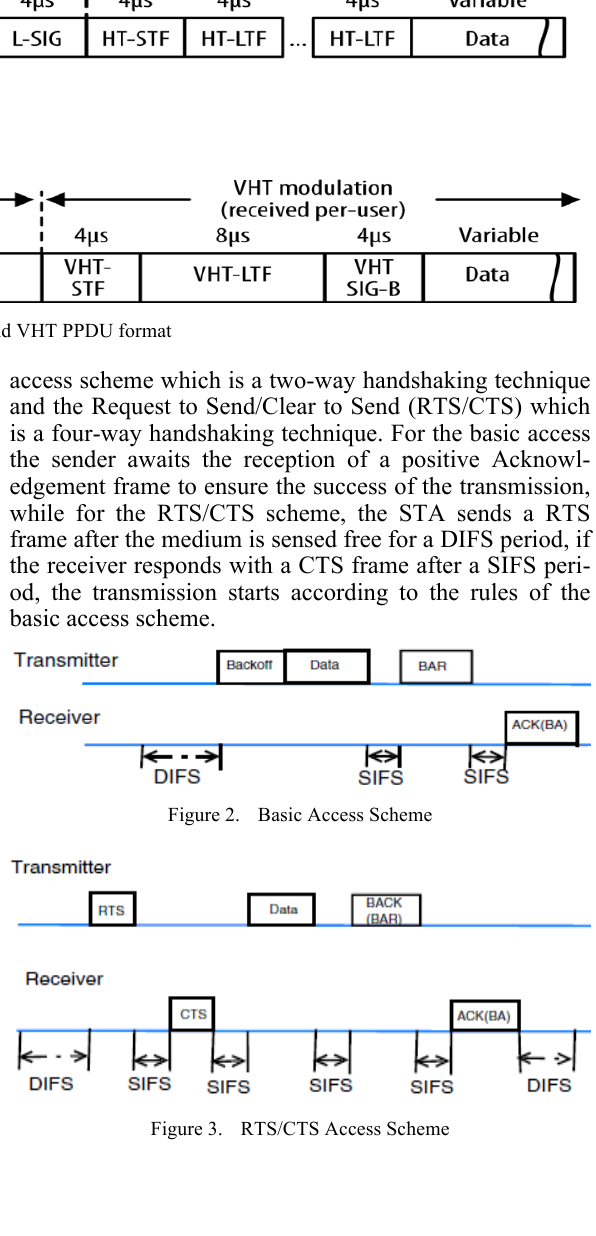
Figure 3. RTS/CTS Access